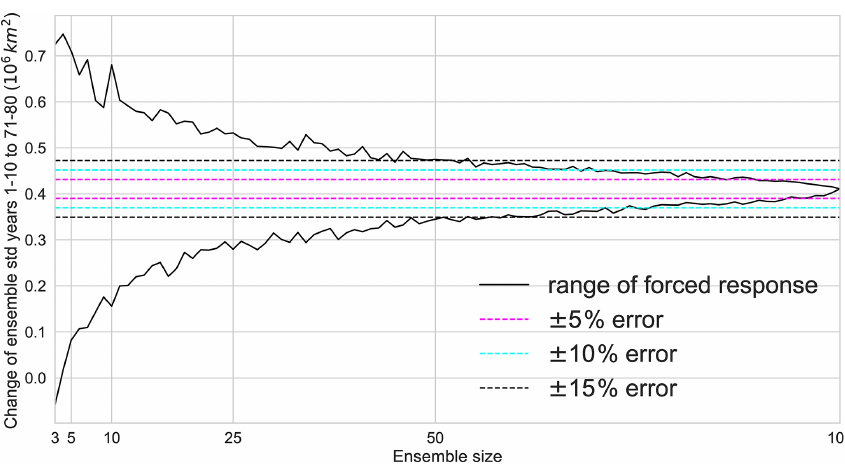
Figure 8. Change in internal variability of September Arctic sea ice is from the first decade to years 71–80 in a 1% CO 2 experiment. For different ensemble sizes, we compute the ensemble standard deviation and then average for the first decade and years 71–80 before computing the difference. Black lines show maximum and minimum change in variability from 1000 random samples. Errors are shown as percentage of the 100-member variability